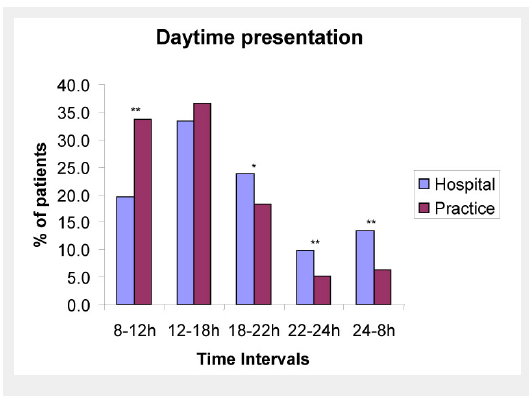
Relative distribution of patients seen for an emergency at different time intervals in percentages; comparison between hospital and general practice. *p <0.01; ***p